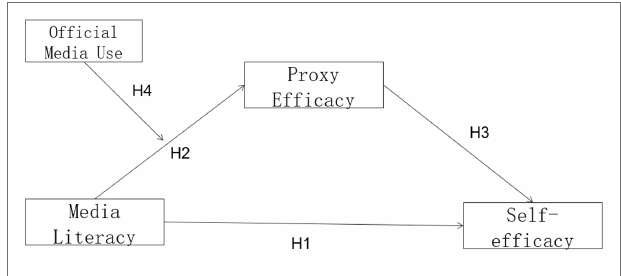
FIGURE 1 | The theoretical model.